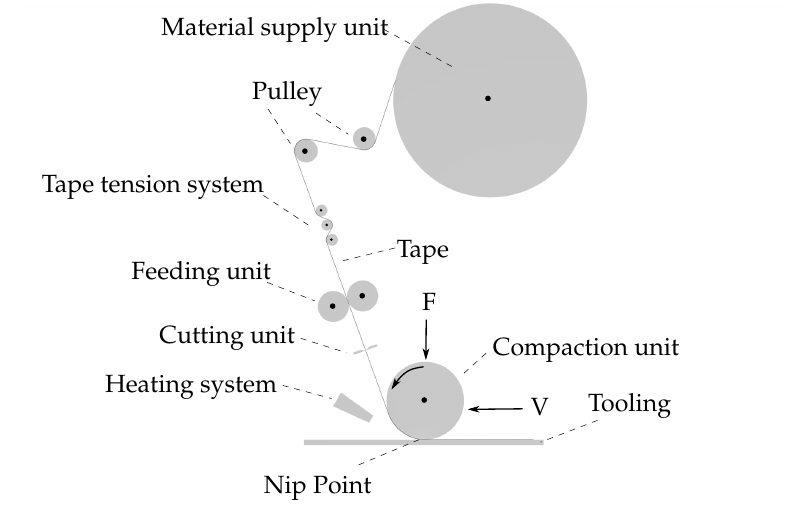
Figure 1. Automated Fiber Placement (AFP)